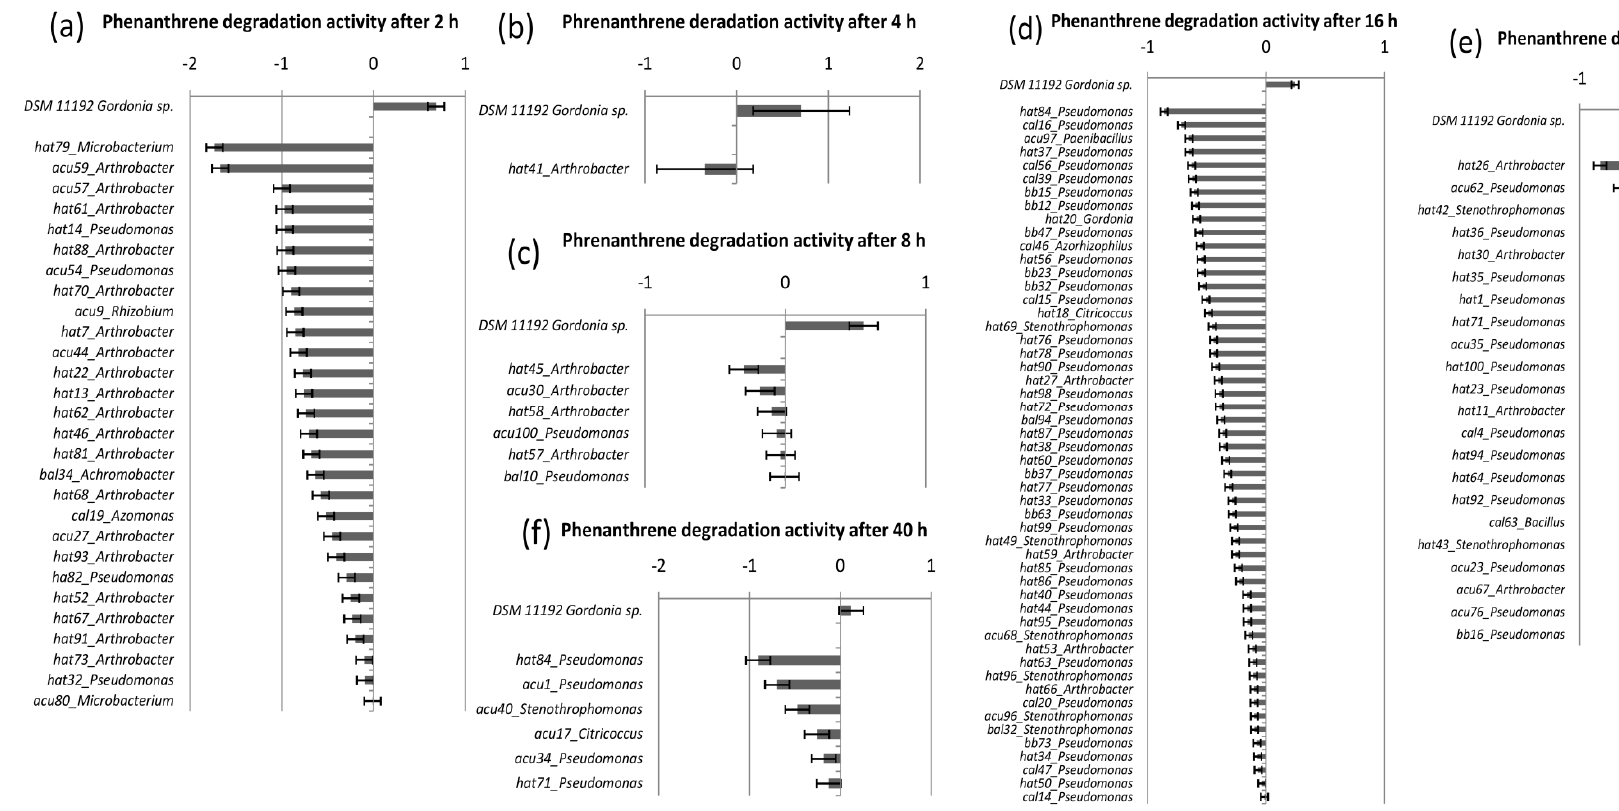
Figure 1. Visualization of the best isolates rates for the degradation of 0.05% of phenanthrene after ( a ) 2 h; ( b ) 4 h; ( c ) 8 h; ( d ) 16 h; ( e ) 24 h; and ( f ) 40 h; measured at 620 nm. Negative data indicate degradation. The positive control is at the top of the figure, and the genus of each isolate is